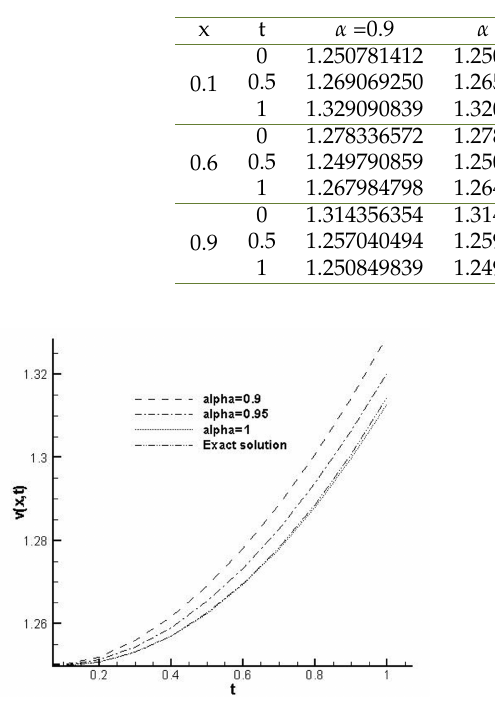
Fig. 2. Solution of Eq. (16) using the 3-iteration of DJM for several values of α when, x=0.1